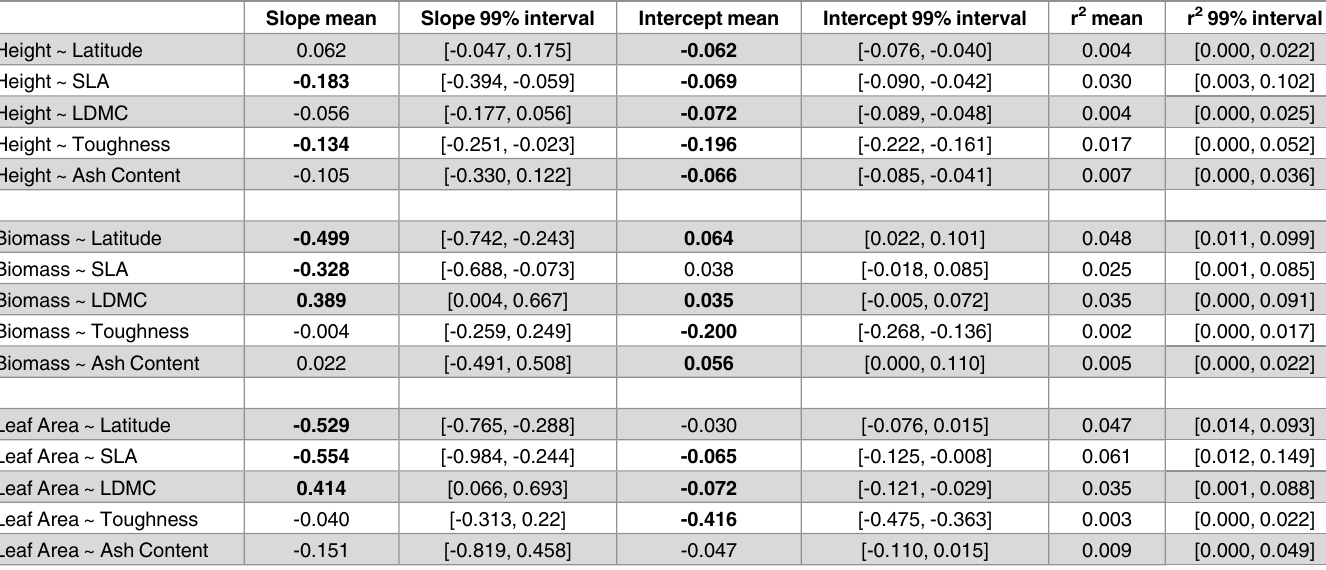
Table 2. Leaf-level traits and latitude can predict whole-plant responses to